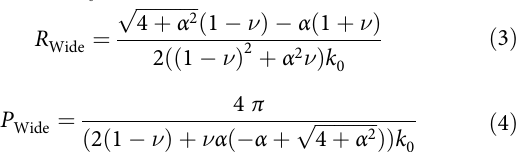
, as a function of α . c Measurements of P (top) and R Wide ¼ 0 : 03 rad , α = 0.1, t = 3.4 nm and the fi tted 0 nm